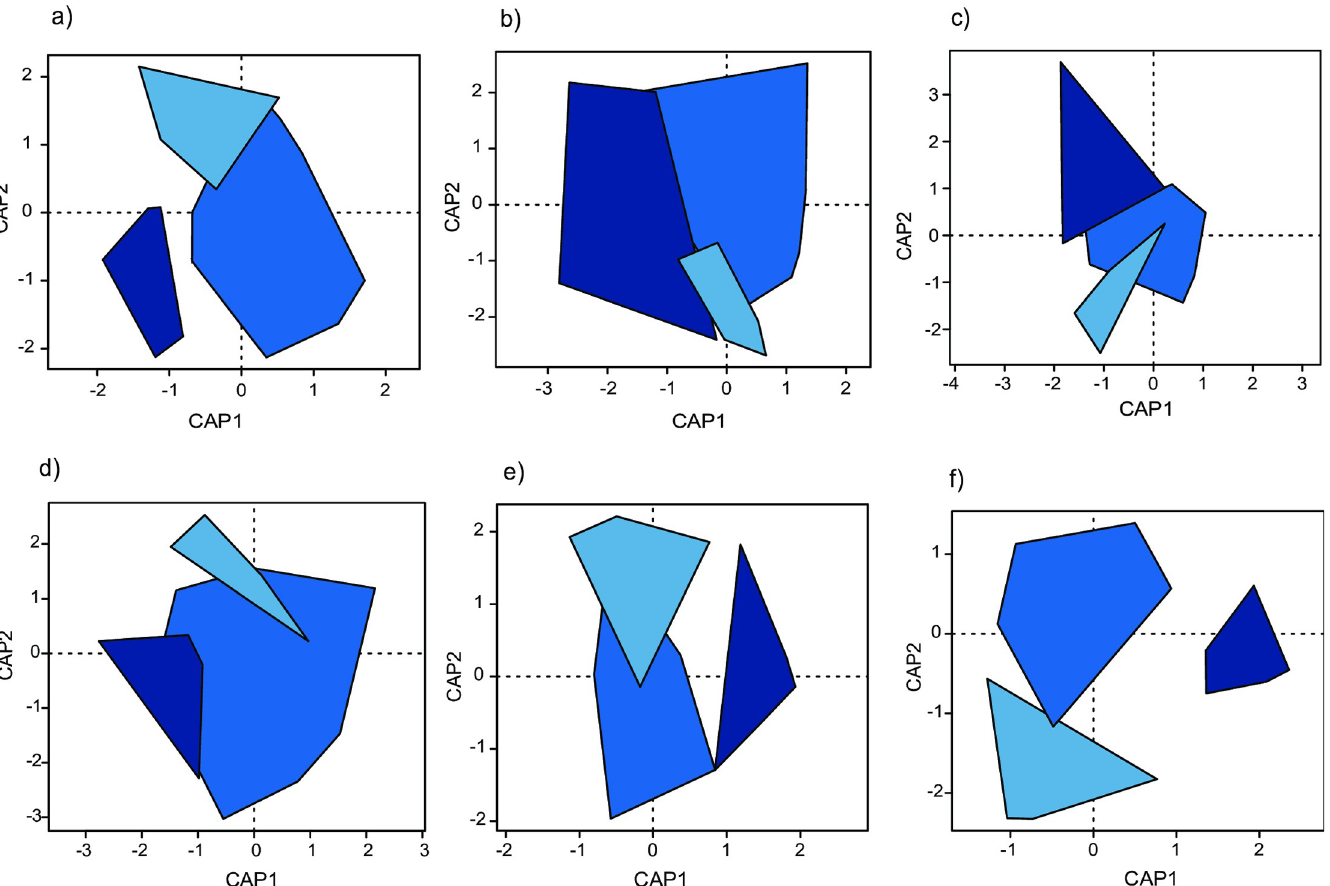
Fig 2. Results of constrained analyses of principle coordinates visualizing similarities in species compositions of gastropods (a), spiders (b), millipedes (c), woodlice (d), ants (e), and rove beetles (f) in gardens located at different distances to the city centre (three classes; dark blue refers to gardens in the centre of the city, blue to gardens at intermediate distance and light blue to gardens at long distance from the city